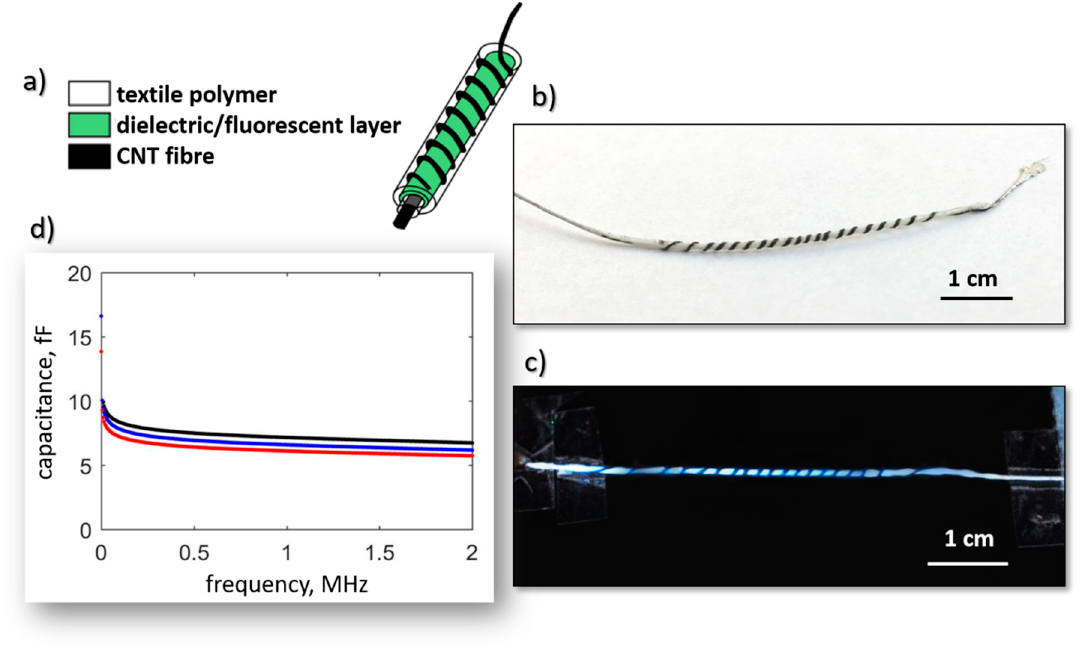
Figure 4. ( a ) Design of a luminescent capacitor and ( b ) an image of the manufactured element. ( c ) Powered manufactured element. ( d ) Capacitance of three luminescent capacitors as a function of frequency.